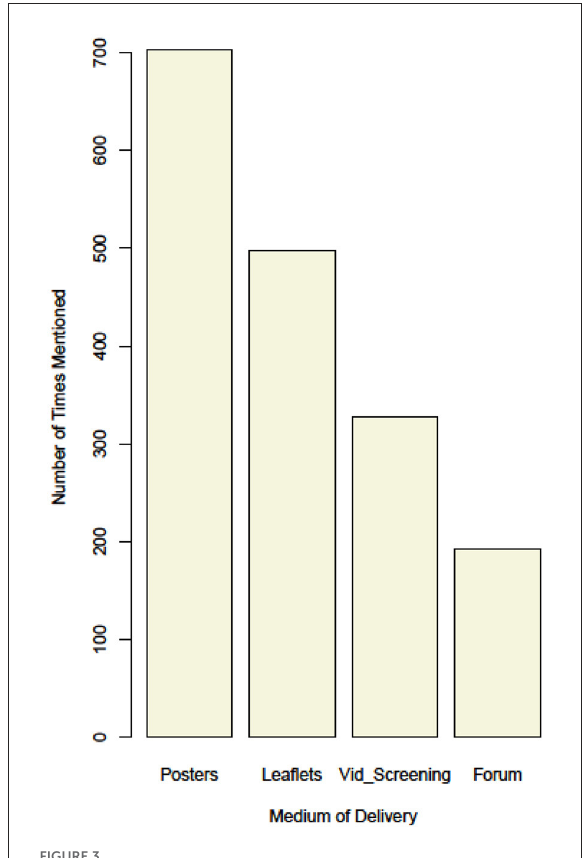
FIGURE3 Reach of intervention media among follow up survey participants.